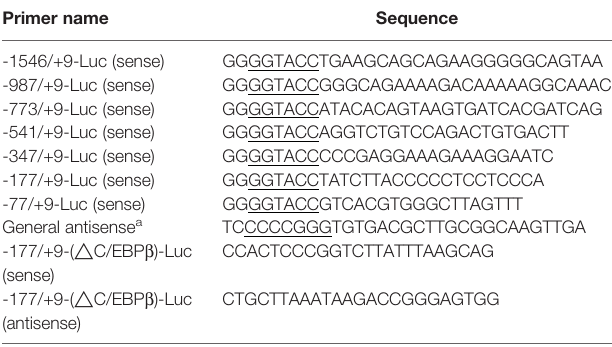
TABLE 1 | Primers for truncated and deleted sequence of COX-2 promoter.